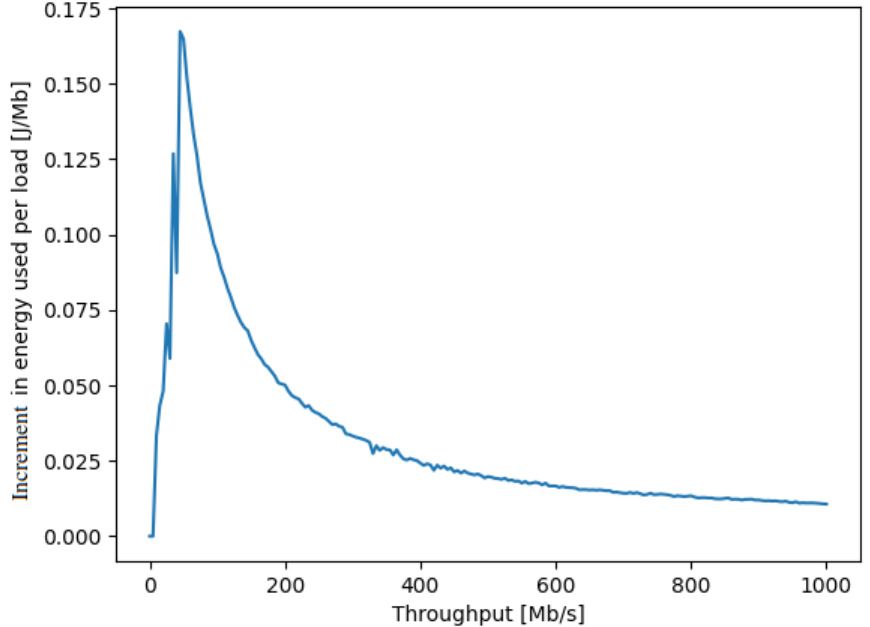
Figure 3. The increment in the amount of energy in Joules per Mb transported through a NUC acting as a SDN switch (shown on the y axis), as a function of the ongoing traffic rate in Mb/s passing through the NUC (shown on the x axis). This curve shows that if we operate the NUC at the left-hand side of the peak of the curve, increasing the traffic will also increase the energy per unit traffic, while if the NUC is operated at the right-hand side of the peak, then as we add on more traffic through the NUC, the energy per Mb actually